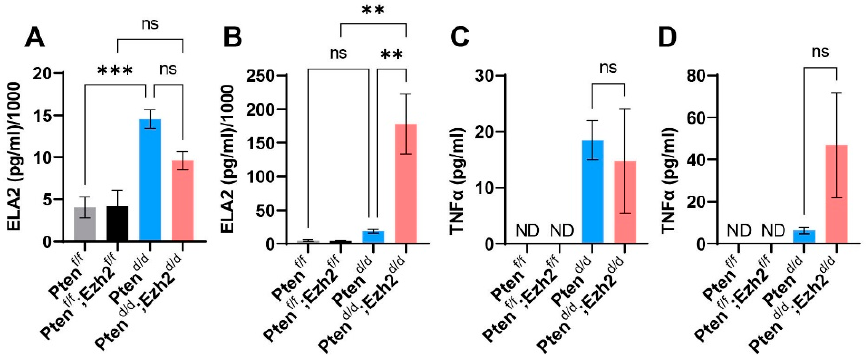
Figure 5. Analysis of ELA2 and TNF α levels using ELISA. ( A , B ) Serum levels of ELA2 at the age of one month ( A ) and nine weeks ( B ). ( C , D ) TNF α levels in uterine tissues at the age of one month ( C ) and in the serum at nine weeks ( D ). n = 3–4. Data are mean ± s.e.m. ** p < 0.01 and *** p < 0.001. ns, not significant. ND, not detected.